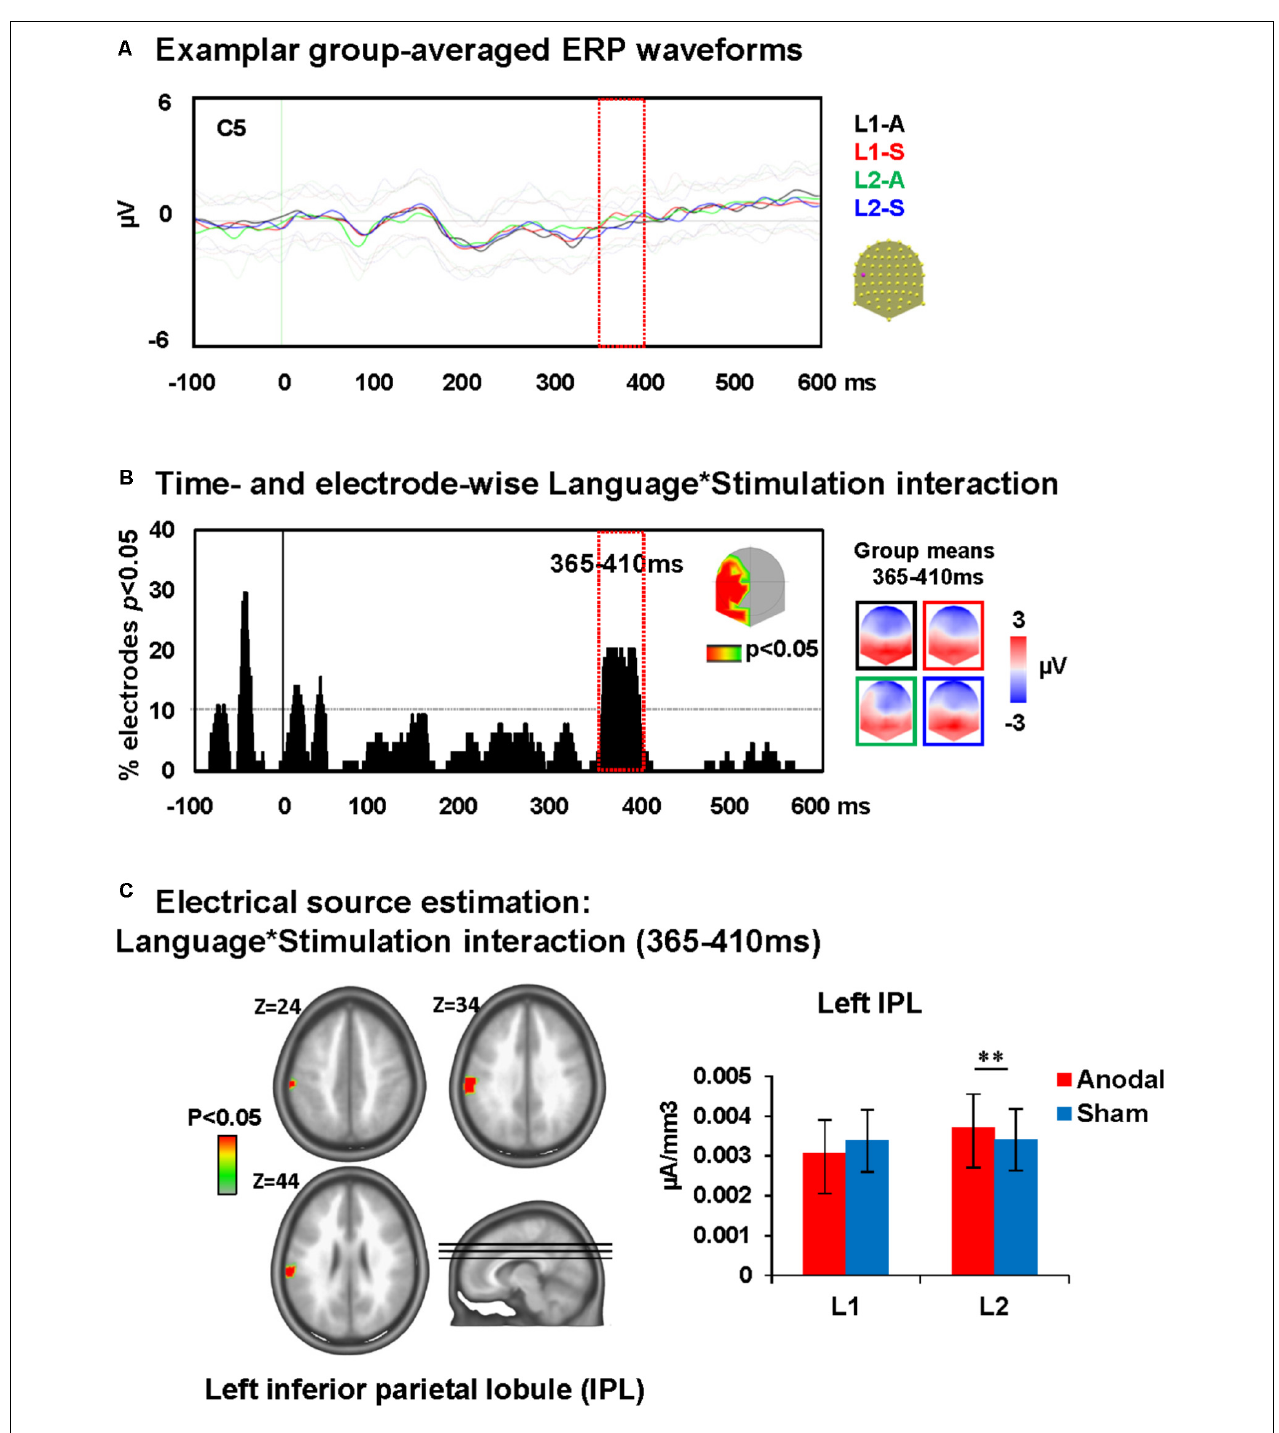
FIGURE 4 | Electrical neuroimaging results: effects of DLPFC tDCS on picture naming ERP modulations. (A) Superimposed ERP waveforms for the four conditions of interest (Naming L1-anodal, Naming L1-sham, Naming L2-anodal, and Naming L2-sham) at one exemplary electrode (C5). This figure includes also the standard deviation of the waveforms for each condition (appear in lighter colors). (B) Time and electrode-wise statistical analyses of the ERPs. The graph depicts for each post-stimulus time point the percentage of electrodes showing a significant Language × Stimulation interaction ( p < 0.05). The 365–410 ms period showed a sustained interaction effect ( > 11 ms for > 10% of the electrodes; light orange square). The topographic map represents the electrode sites showing a significant interaction, and on the right the ERP topography for all groups and conditions at the time window of significant interaction [same colors as in (A) ]. The topographic map of Naming L2-anodal is different from the other three conditions. (C) Statistical analysis of the distributed electrical source estimations over the period of significant Language × Stimulation interaction defined in (C) ( p < 0.05; K E > 14). Z coordinates are indicated on upper left of each MRI slide. ∗∗ p < 0.01.